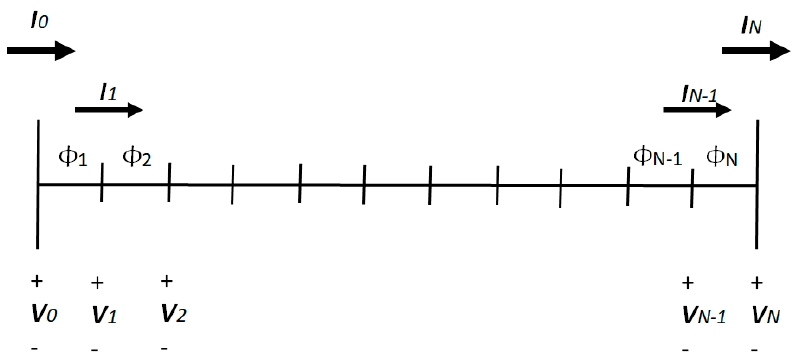
Figure 2. Cascaded connection of chain matrices, where Φ n , V n , and I n are the chain matrix, sending voltage, and sending current of the n -th cascade-connected line, respectively.